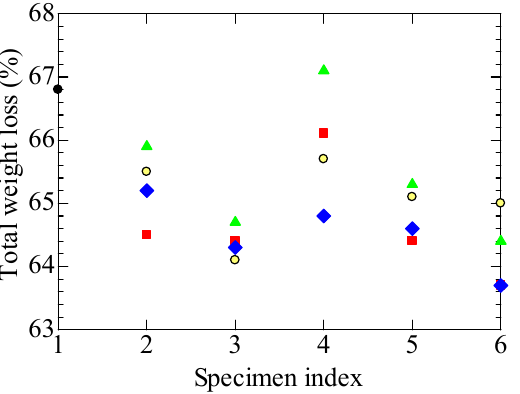
Figure 8. Losses in total weight in a range of 50 to 900 °C, measured at each stage for various tubular specimens. Refer to Tables 1 and 2 and Figure 4 for the meanings of the numerals on the abscissa and sample symbols. Several data may overlap each other.